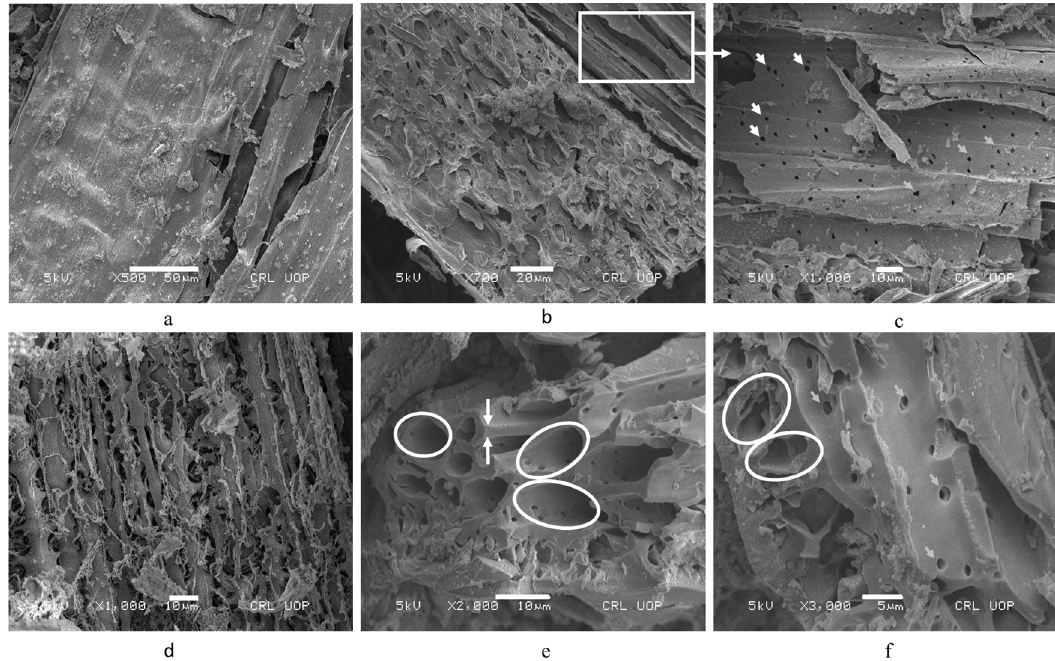
Figure 2. Morphology of wheat straw in longitudinal section ( a – c ) and cross section ( d – f ). Figure 3. SEM of WSA at varying magnification levels, ( a – d ): The fibrous nature of WSA at the macroscopic scale has also been retained at the microscopic level; ( e , f ): WSA particles containing micro-perforations, micro-tubules’ of diameter be- tween 0.25 to 2 µm and 2 to 7 µm, respectively.